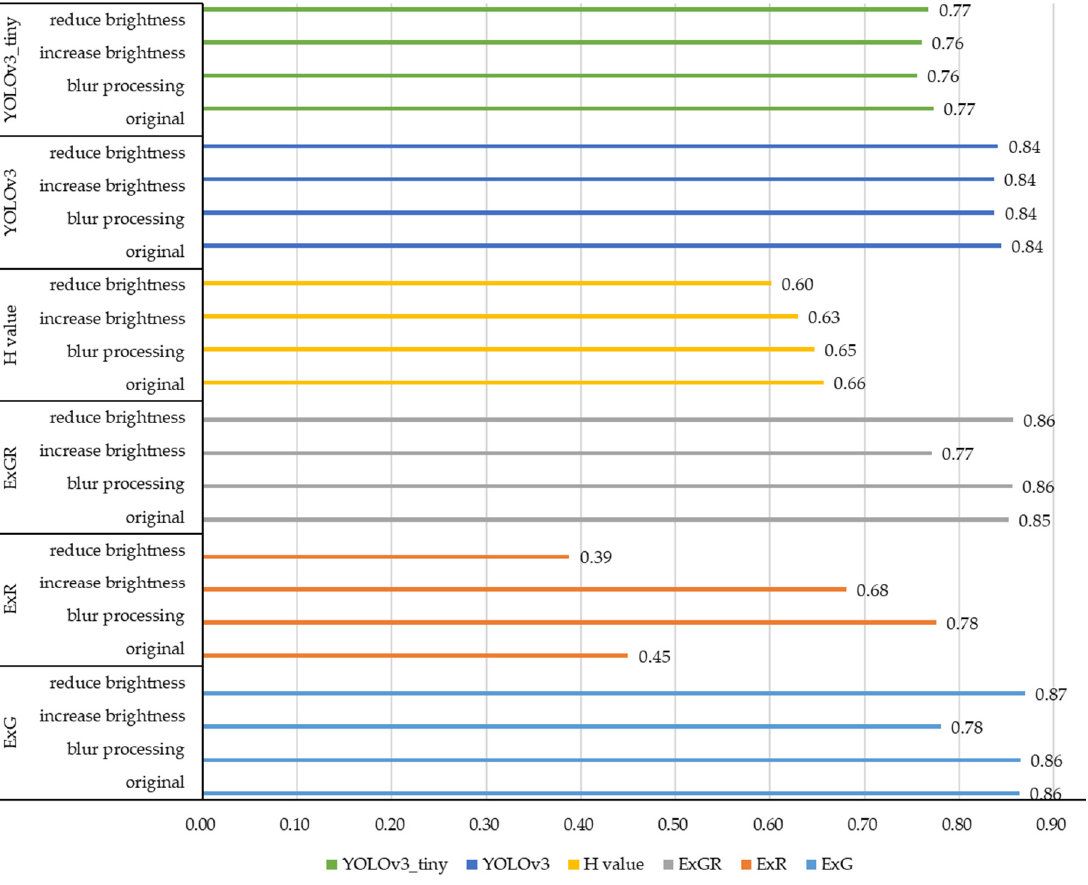
Figure 12. Average intersection over union (IOU) scores of each detection method across different sub–datasets, namely original image, increased brightness, decreased brightness, and blur processing.